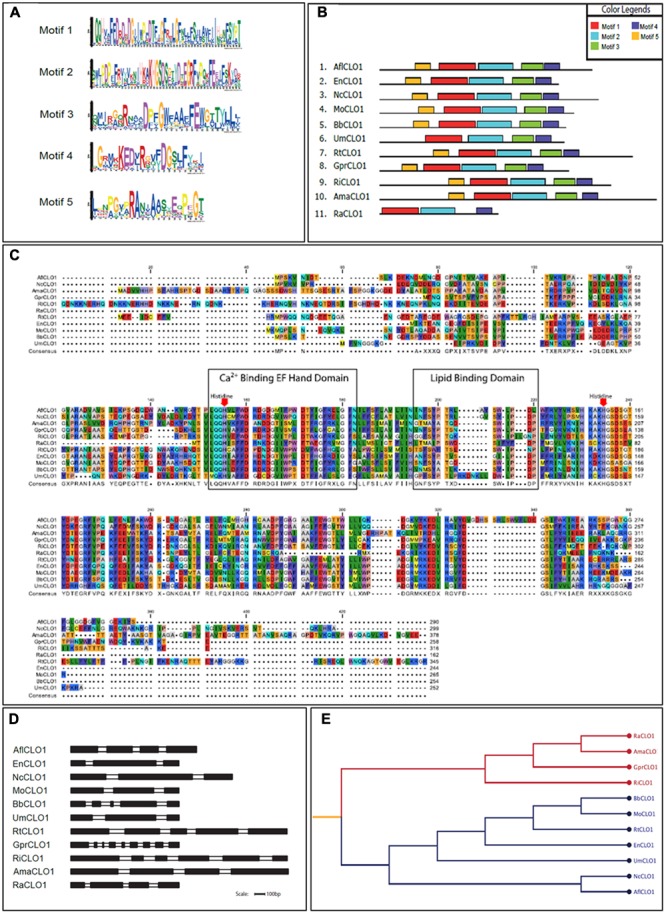
Bioinformatics analysis of caleosin sequences derived from the genomes of A. flavus and other representative fungal species. (A) Motif sequences generated from fungal caleosin protein sequences using http://meme-suite.org/. (B) Block representations of the location on caleosin sequences of the five predicted motifs shown in panel (A). Each motif is color coded as shown in the upper right box. (C) Amino acid multiple sequence alignment of caleosins from selected fungal species. Multiple alignments were performed using Clustal Omega (ClustalO) from https://www.ebi.ac.uk/Tools/msa/clustalo/. The CLC sequence viewer from CLCBio was used to inspect the alignments. Caleosins were obtained from the NCBI database (http://www.ncbi.nlm.nih.gov) under accession numbers presented in Supplementary Table S4. Domain properties of the proteins were analyzed using the UniProt platform (http://www.uniprot.org). Color coding is as follows: the multiple sequence alignment residues are colored according to Rasmol amino color scheme, first boxed residues indicate the combined Ca2+ binding EF hand domain and second boxed residues indicate the lipid binding domain. The invariant heme-binding histidine motif is marked in red with down arrows. (D) Intron/exon structures of selected fungal caleosin genes generated using WebScipio. Exons are depicted as solid bars while introns are clear bars. Scale bar is 100 bp. (E) Phylogenetic tree to represent the cladistic relationship between A. flavus and other representative fungal species. Sequences from the more advanced Dikarya species, including A. flavus, are shown in blue and sequences from the more basal and divergent taxa are shown in red.